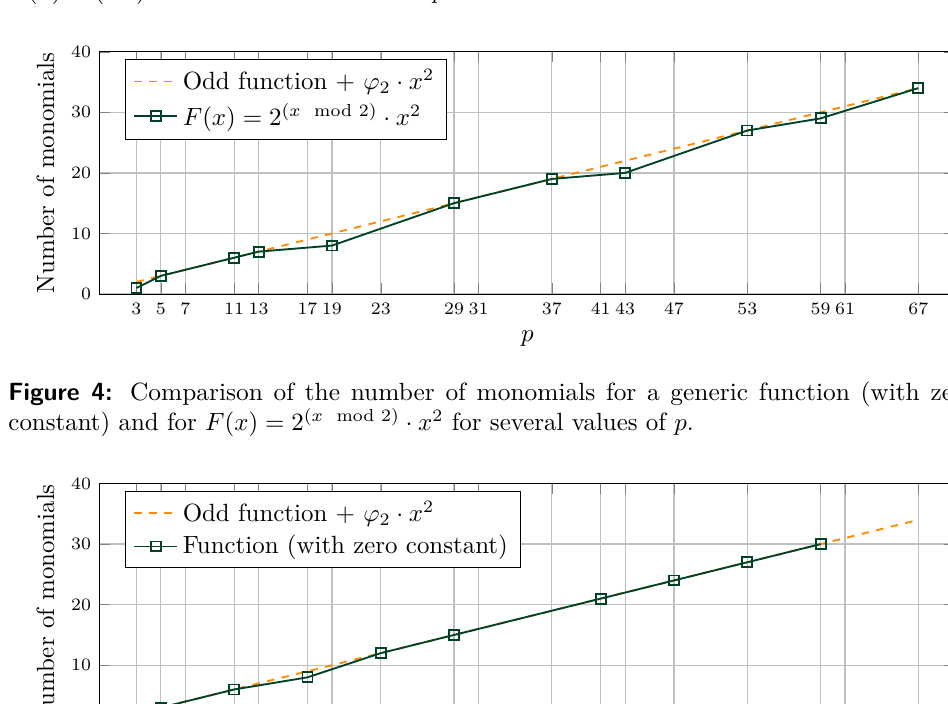
Figure 3: Comparison of the number of monomials for a generic odd function and for F ( x ) = ( − 1) x · x 2 for several values of p .